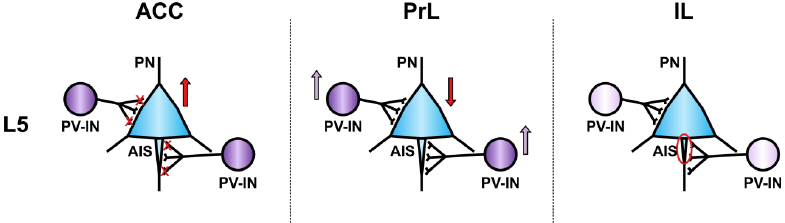
Figure 1. Subregion-specific modification of mPFC L5 pyramidal neurons by PV+ GABAergic interneurons in pathological pain. In the ACC, the number of synapses formed by PV+ interneurons (PV-IN, purple) is decreased (red crosses), which leads to disinhibition of pyramidal neurons (PN, blue) and hyperexcitability; in the PrL, PV+ interneurons increase their feed-forward inhibition onto pyramidal neurons, thereby decreasing pyramidal neuron excitability; in the IL, PV content is decreased (faint purple) in PV+ interneurons and axon initial segment (AIS) of pyramidal neurons is shortened (red circle), which has been associated with decreased pyramidal neuron excitability [90].